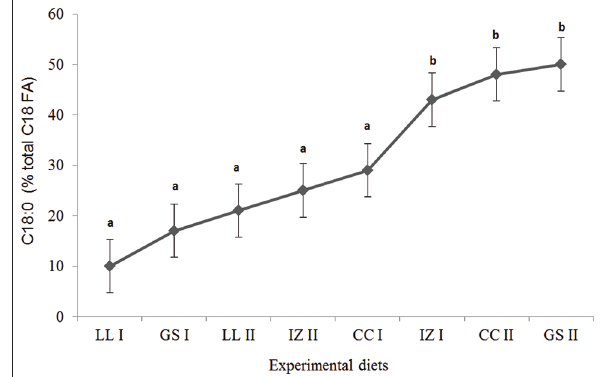
Figure-2: C18:0 composition of rumen fluid after 48 h incubation (% total C18 FA). LL I=50% Pennisetum purpureum + 50% Leucaena leucocephala ; LL II=75% P. purpureum + 25% L. leucocephala ; GS I=50% P. purpureum + 50% Gliricidia sepium ; GS II=75% P. purpureum + 25% G. sepium ; IZ I=50% P. purpureum + 50% Indigofera zollingeriana ; IZ II=75% P. purpureum + 25% I. zollingeriana ; CC I=50% P. purpureum +